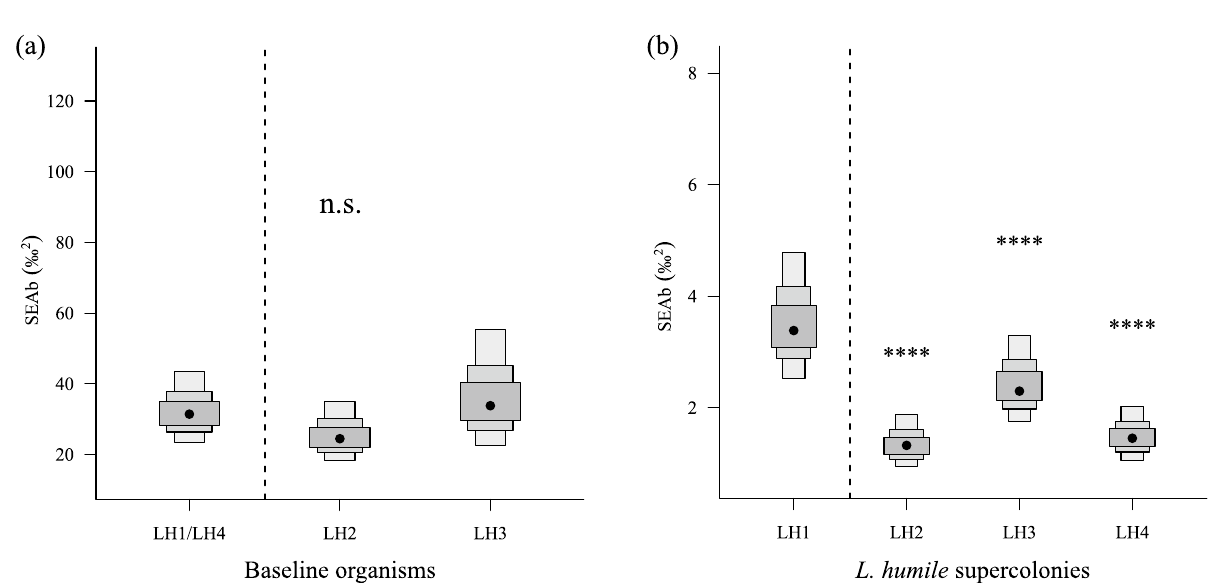
Figure 5. Comparisons of Bayesian standard ellipse area ( , SEAb: 10 5 Bayesian iterations of SEA) among ( a ) baseline organisms collected within the sampling site of each supercolony (LH1/LH4, LH2, and LH3) and ● among ( b ) the four Japanese L. humile supercolonies, with 50%, 75%, and 95% credible intervals (CIs) shown, using the R package “SIBER” 32 . Asterisks indicate the significance of the pairwise differences between LH1 and the other supercolonies [*0.6 ≤ P < 0.69, **0.7 ≤ P < 0.79, ***0.8 ≤ P < 0.89, ****0.9 ≤ P ≤ 1; P is the likelihood of a difference between LH1 and the other supercolonies (or LH1/LH4 and the other sampling sites)] 32